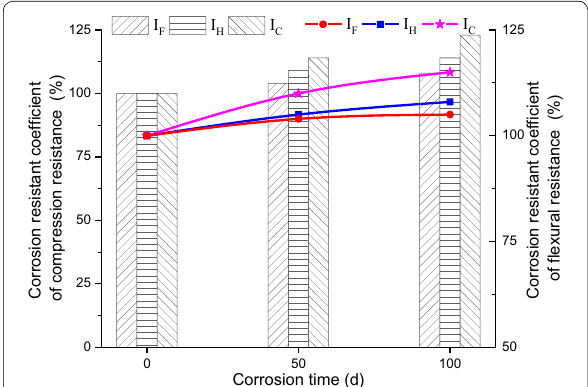
Fig. 6 Effect on strength of C40 concrete caused by three corrosion methods.